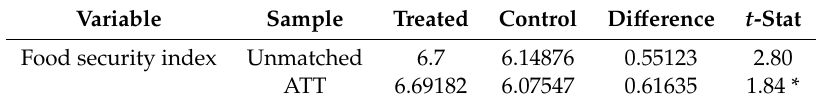
Table 4. Average impact estimates of propensity score matching for food security.